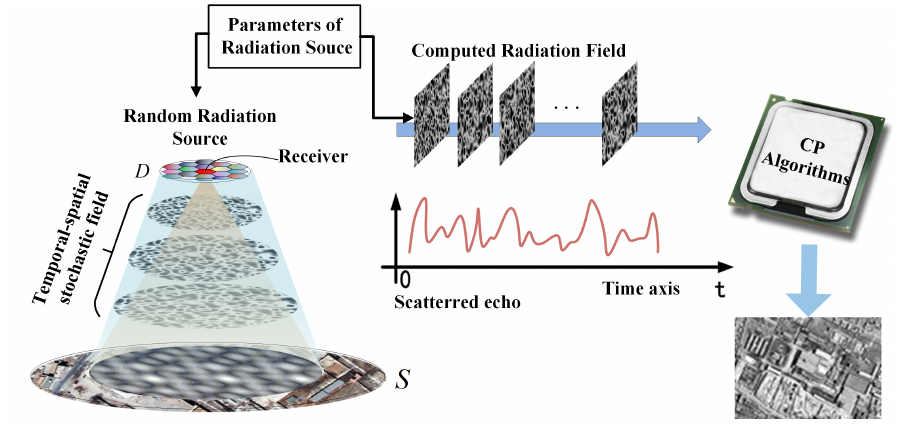
Figure 1. The imaging geometry and procedure of mono-static microwave staring correlated imaging